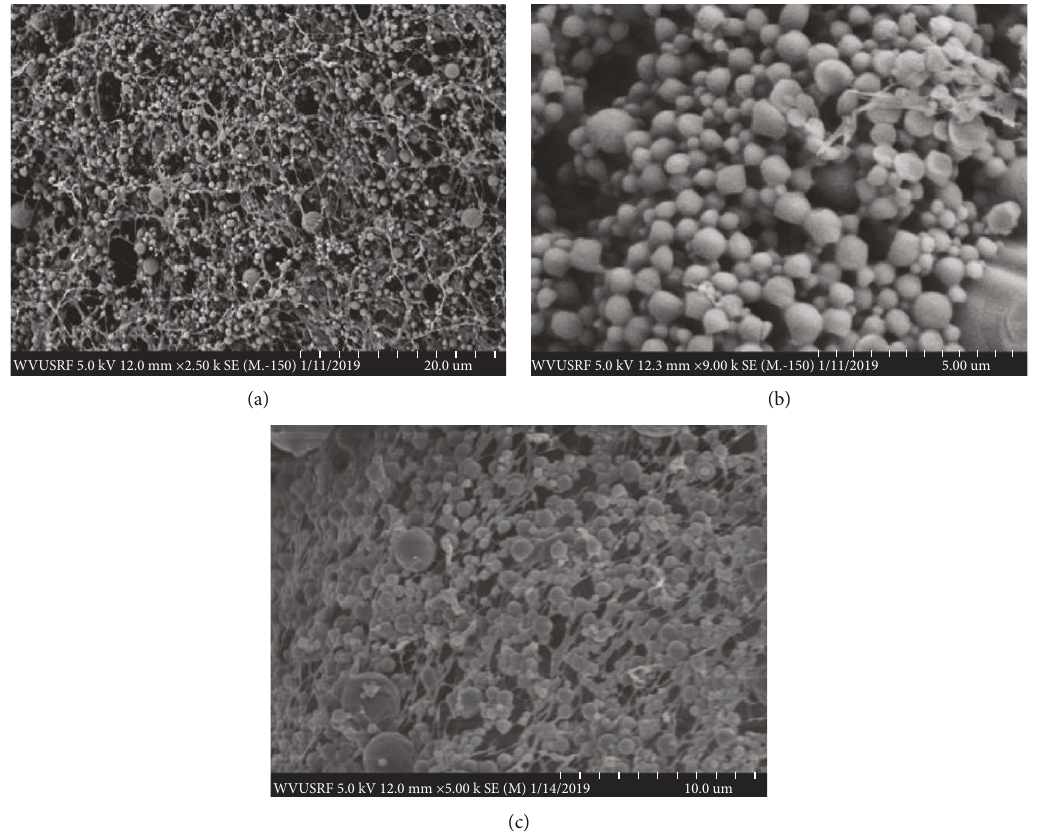
Figure 1: Scanning electron microscopy (SEM) images of unloaded (blank) poly(lactide-co-glycolic) acid (PLGA) nanospheres lyophilized without (a, b) and with (c) 25mM trehalose at 2500x, 9000x, and 5000x magni fi cations,